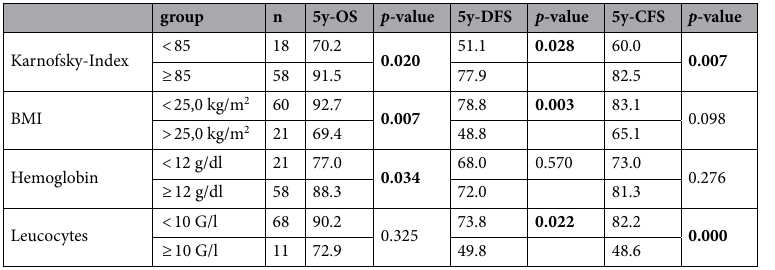
Table 3. KI, BMI, hemoglobin and leucocyte count and clinical endpoints. Kaplan–Meier with log-rank test: OS overall survival, DFS disease free survival, CFS colostomy-free survival. Significant values are in